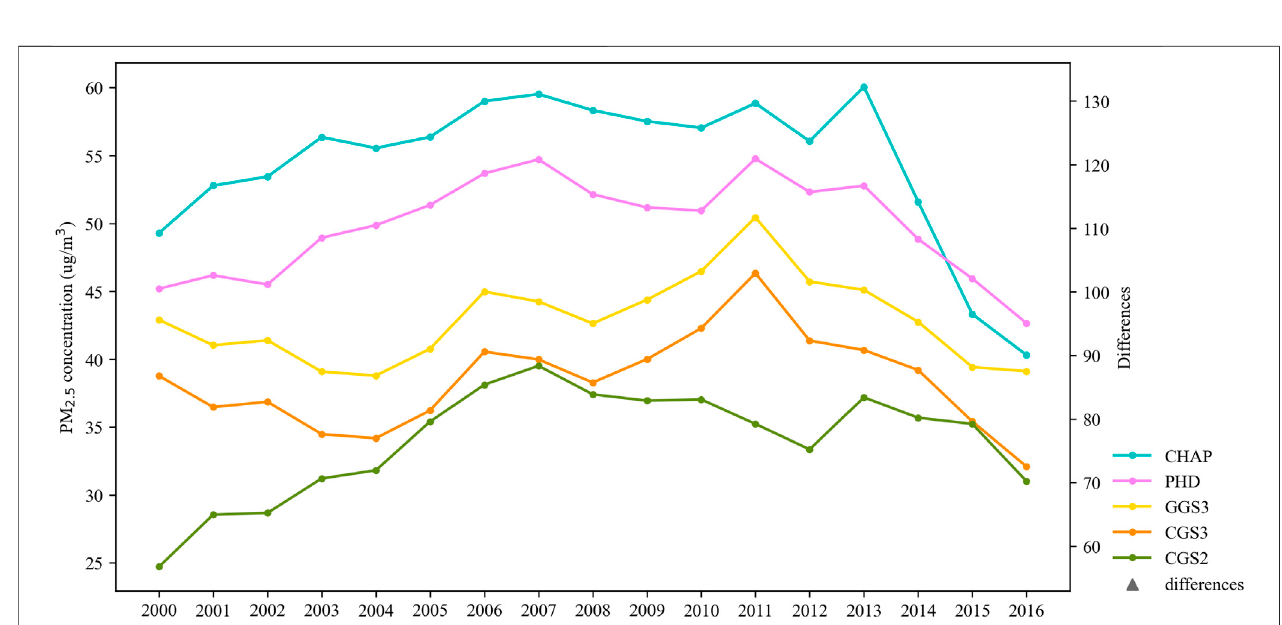
FIGURE 6 | Annual PM 2.5 concentration of fi ve sets of PM 2.5 datasets from 2000 to